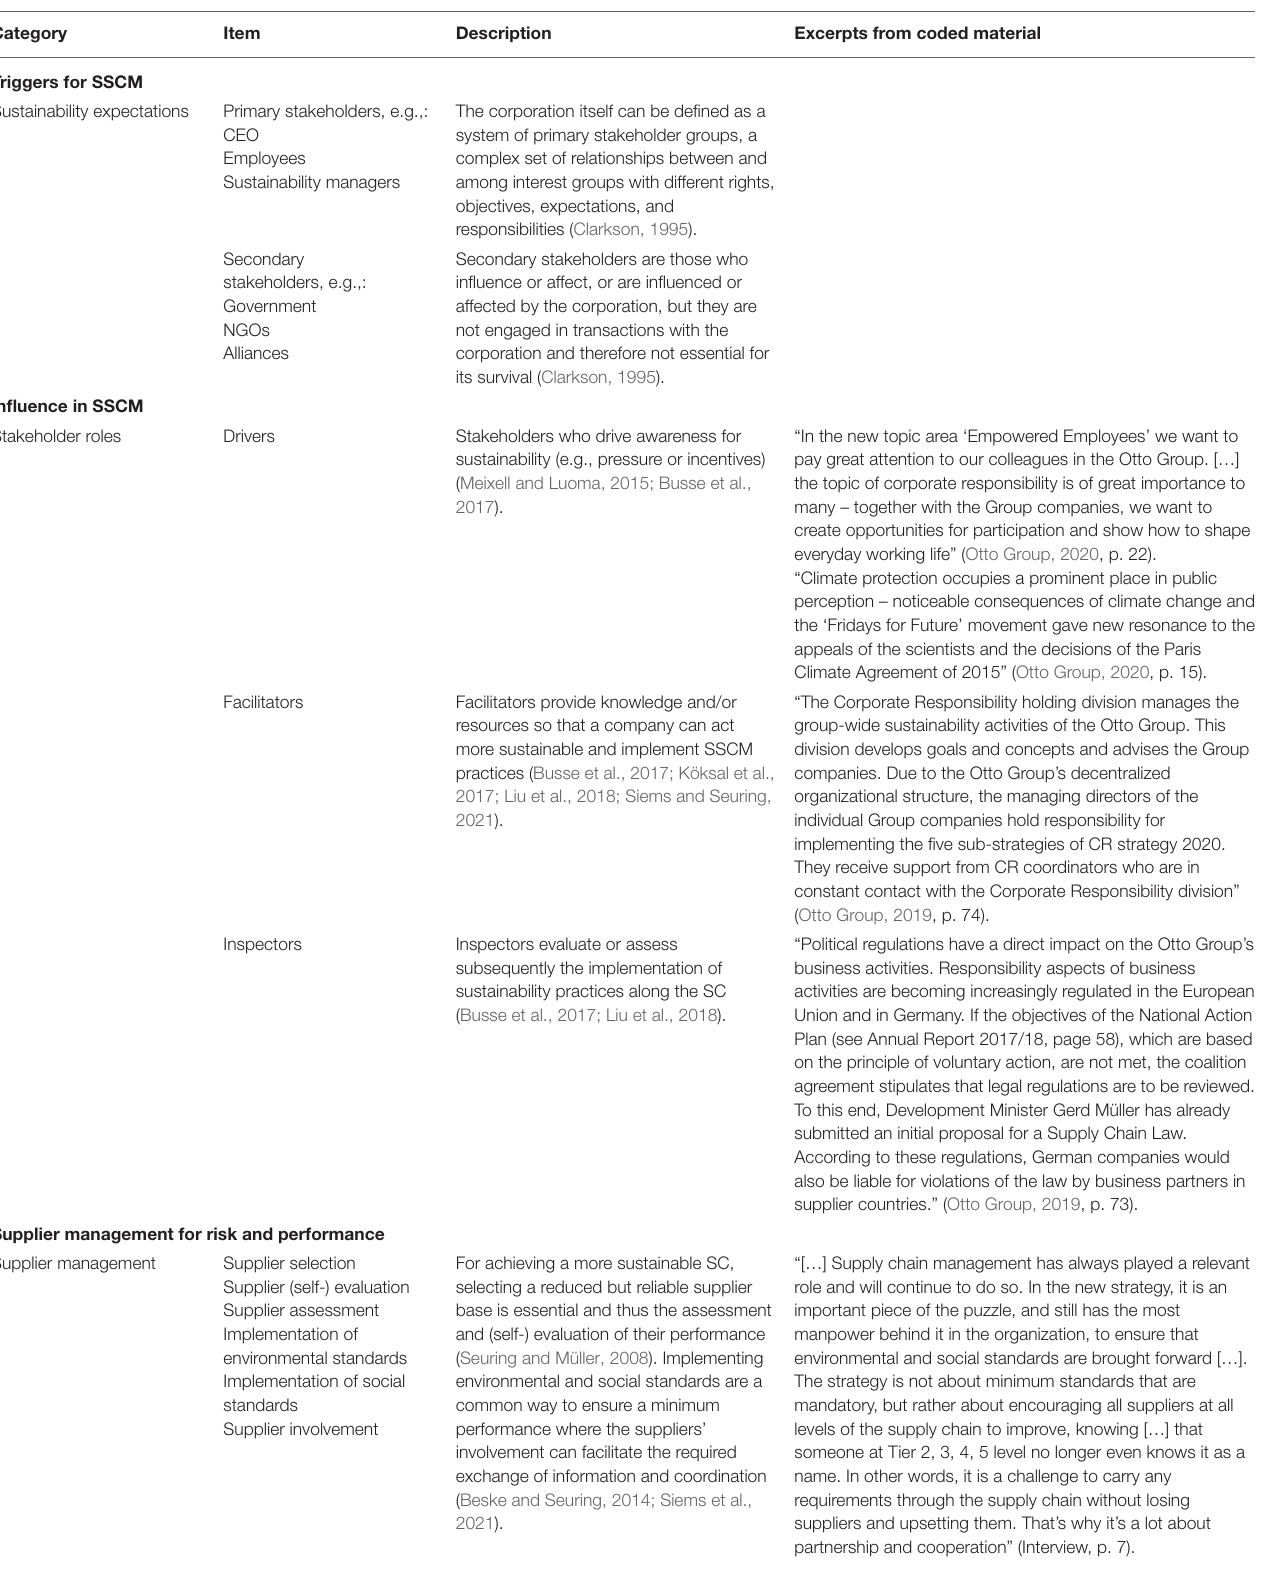
TABLE 1 | Overview of the analyzed SSCM and stakeholder